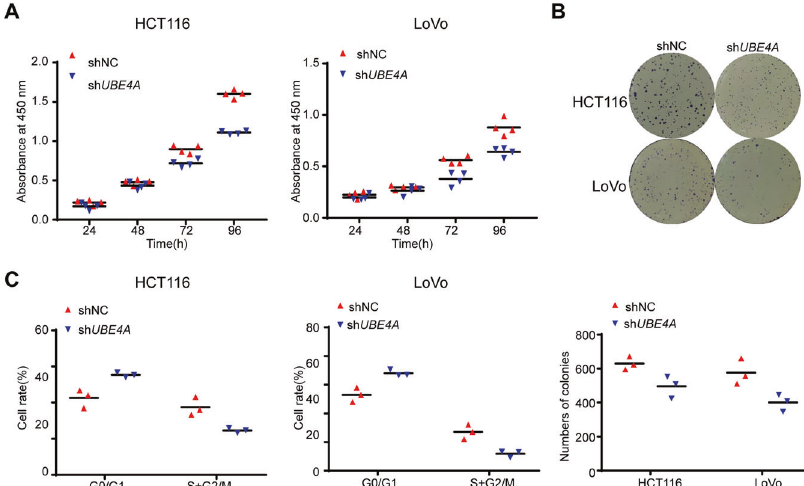
Fig. 4 UBE4A promotes CRC cell proliferation in vitro. A Reduction in the proliferation ability of sh UBE4A HCT116 and LoVo cells compared with that of control (NC) cells using the CCK8 assay (two-way ANOVA, P < 0.01). B Reduction in the colony formation ability of sh UBE4A HCT116 and LoVo cells compared with that of control (NC) cells using the colony formation assay. The bar graph indicates the number of colonies (two-tailed Student ’ s t -test, P < 0.05). C Cell cycle distribution of sh UBE4A HCT116 and LoVo cells compared with that of control (NC) cells was analyzed by fl ow cytometry. The results are presented as means ± s.d. and are representative of at least three independent experiments (two- tailed Student ’ s t -test, P <